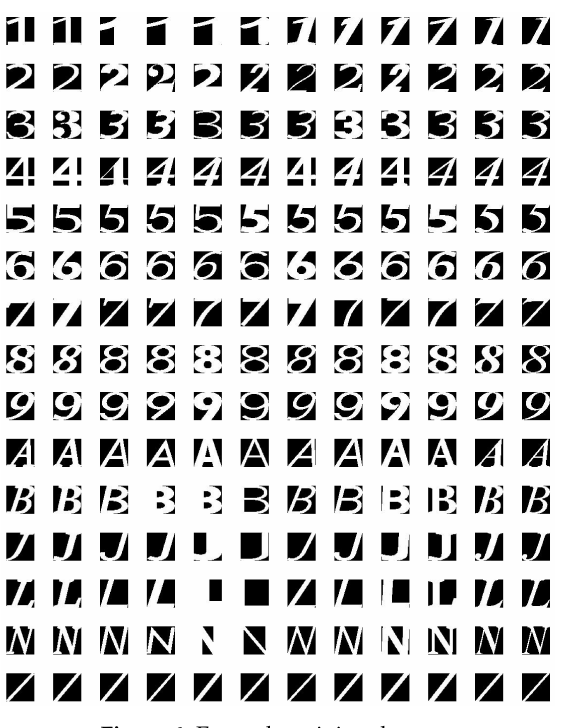
Figure 6. Example training data